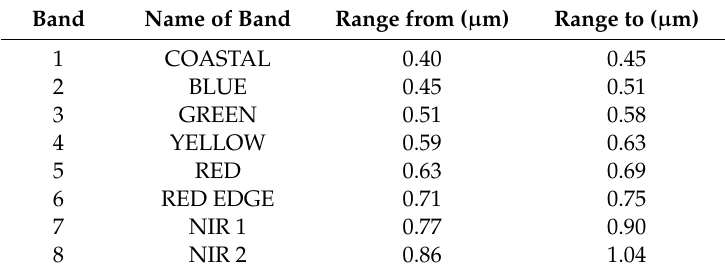
Table 1. Spectral bands of WorldView-2.